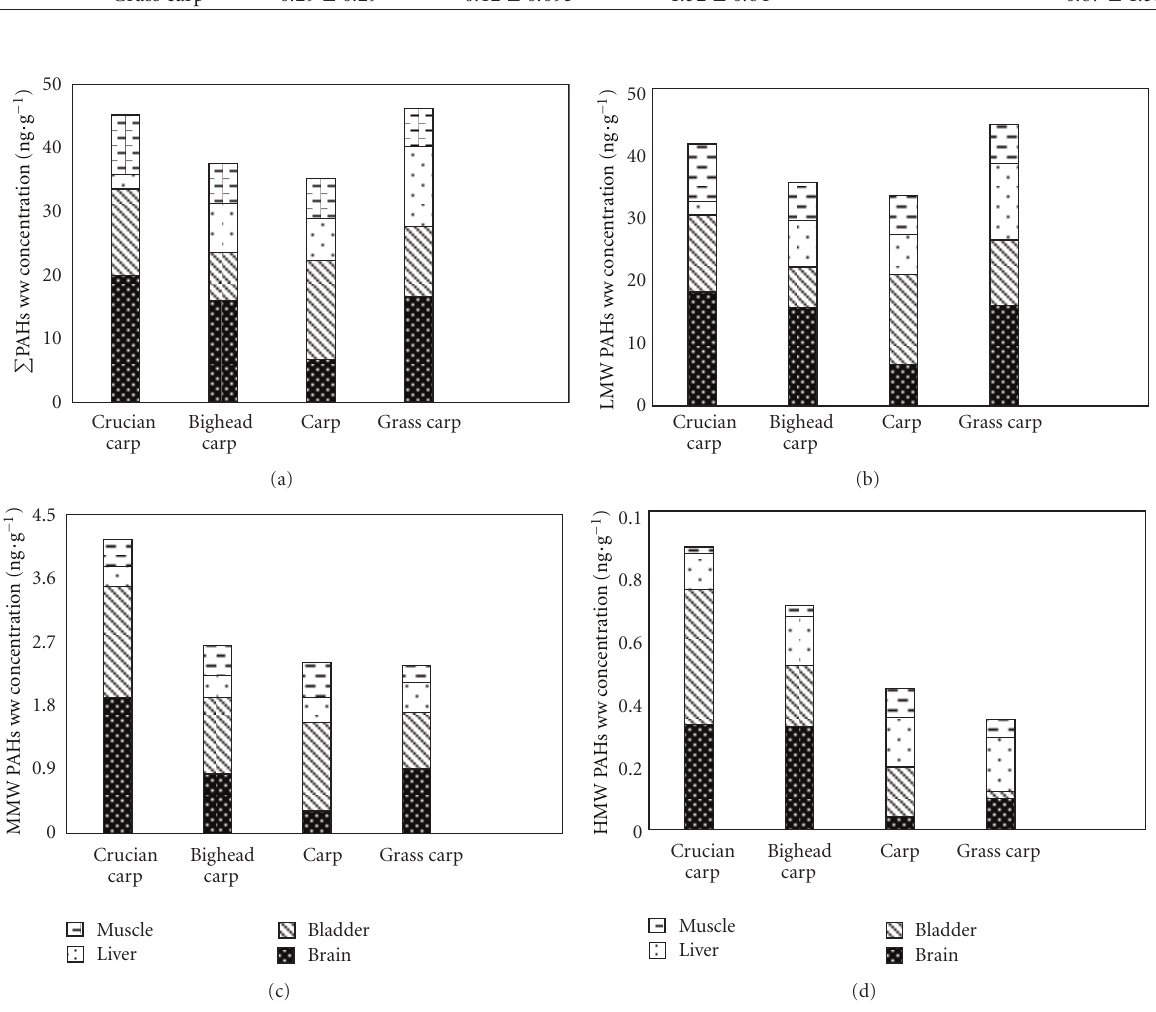
Figure 3: Wet weight contents of (a) total PAHs (PAH16), (b) LMW-PAHs, (c) MMW-PAHs, and (d) HMW-PAHs in four fish